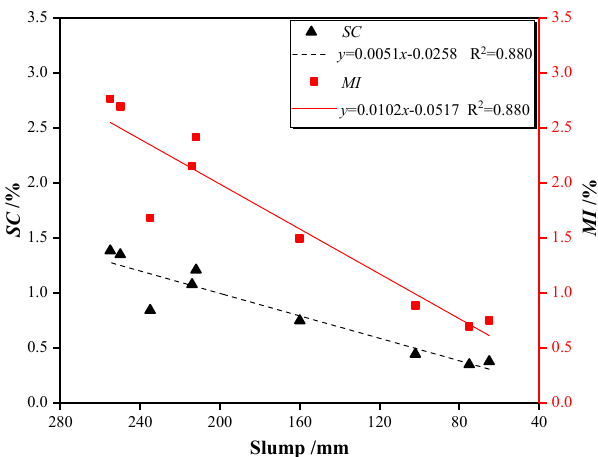
Figure 6. Relationship between the slump value and segregation parameters ( SC and MI ).